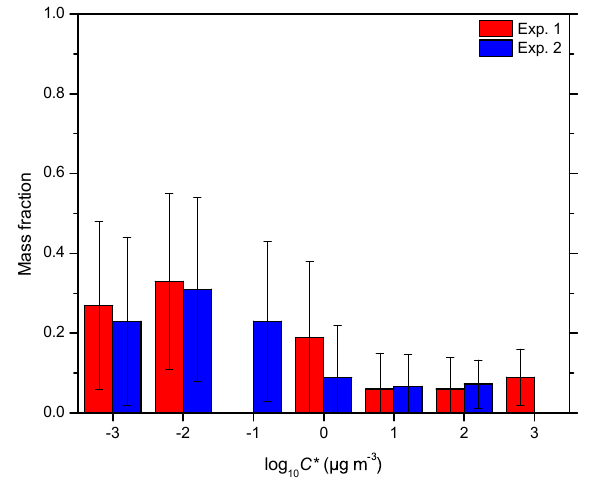
Figure 2. Estimated volatility distributions for Experiment 1 (red bars) and for Experiment 2 (blue bars) using the approach of Karnezi et al. (2014). The error bars represent the uncertainty of the estimated mass fractions.